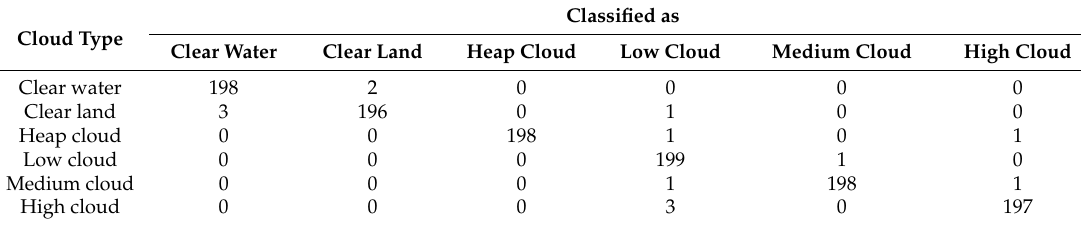
Table 3. Confusion matrix of classification results of different cloud types by AFSRC (K = 5).